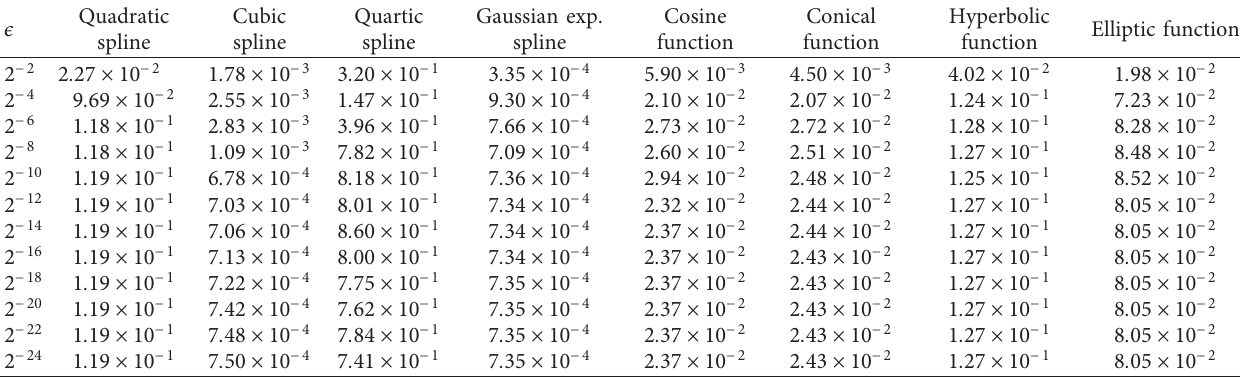
Table 2: Maximum absolute errors for Example 1 for different values of ϵ with quadratic basis functions.